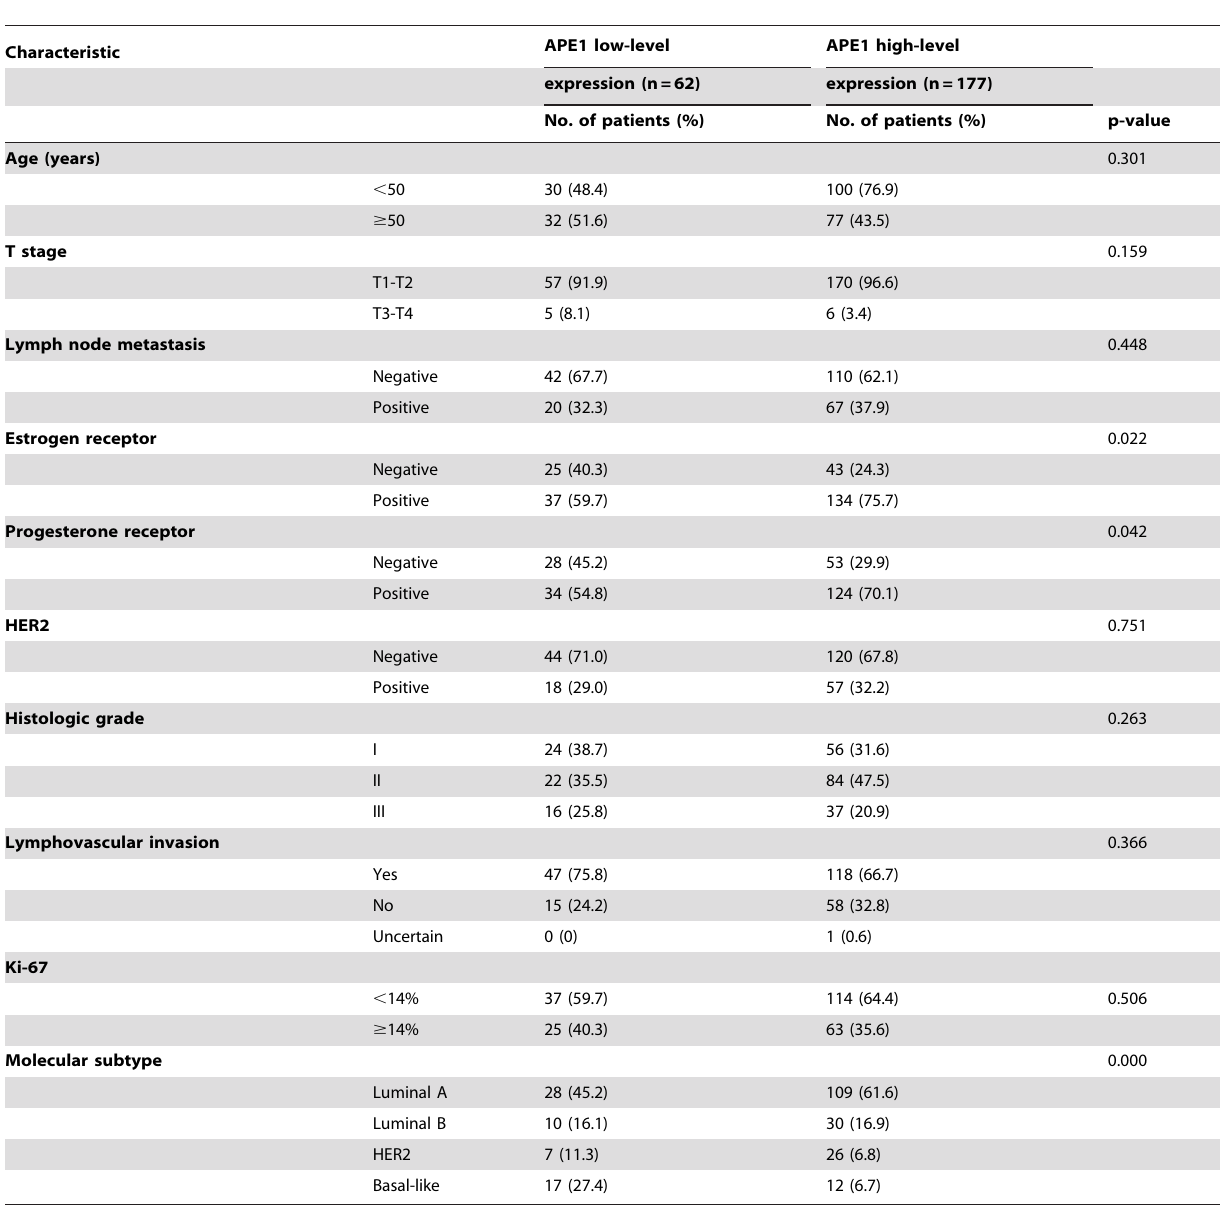
Table 1. Relationship between APE1 expression and clinicopathological parameters.